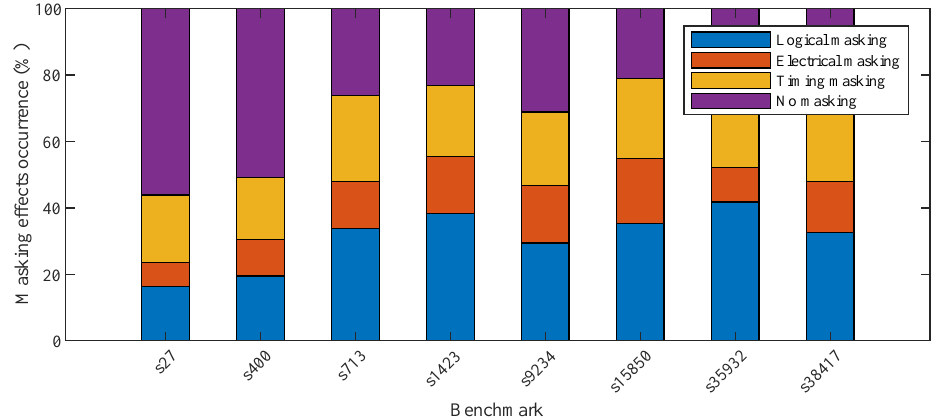
Figure 4. Impact of the masking effects on the propagation of radiation-induced SETs through some benchmark circuits for 45 nm